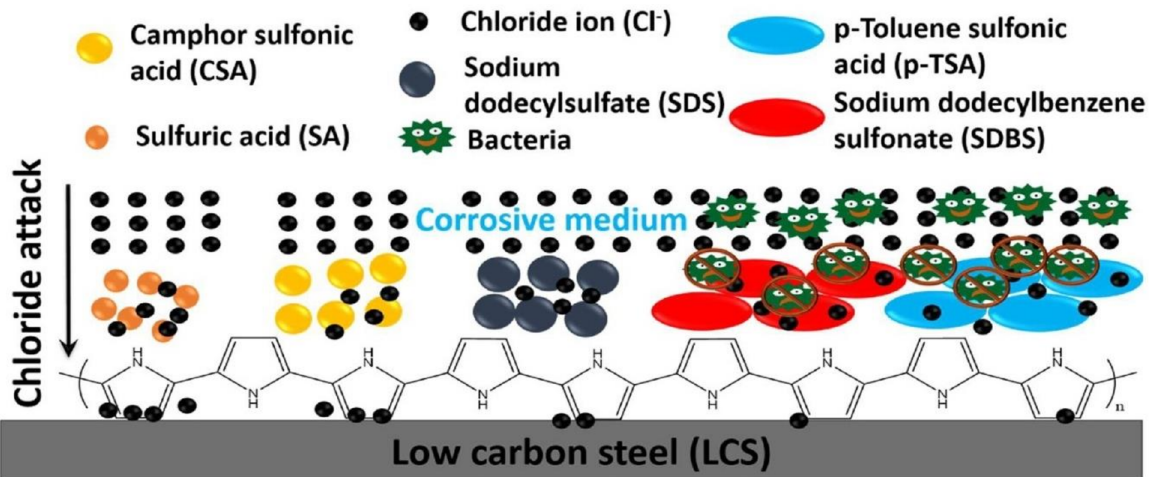
Figure 15. Poly-pyrrole (PPy) polymeric-coatings on carbon-steel for bio-medical applications. Reproduced with permission from